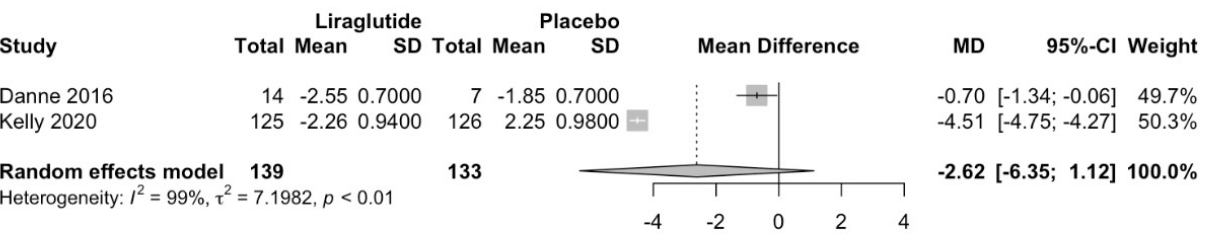
Figure 4. Effect of Liraglutide on Body Weight [30,31].